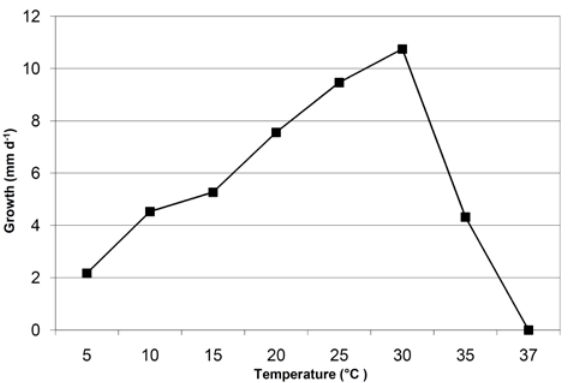
Figure 2. Average radial growth rate of Phytophthora pista- ciae isolates on cornmeal agar at different